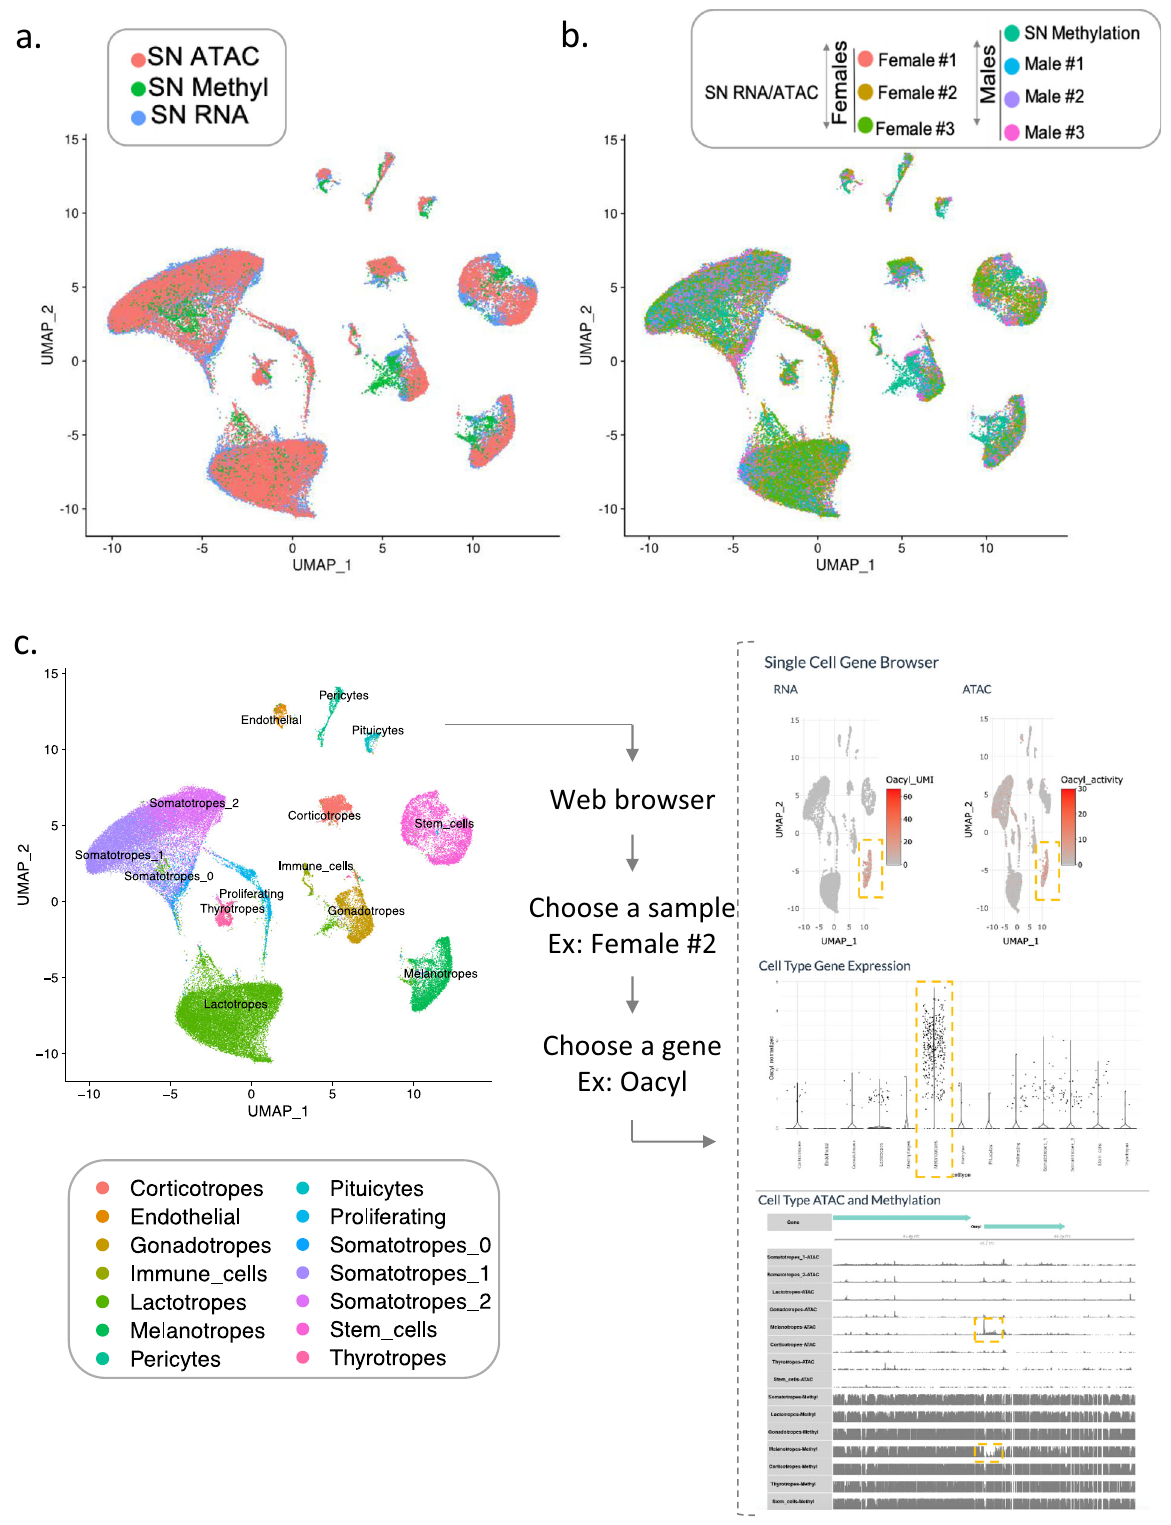
Fig. 5 Multi-omics pituitary cell type integration. a UMAP overlay of the snATACseq (red), snMethyl (green), and snRNAseq (blue) datasets. b UMAP of the overlay of all samples with the three omics modalities. SnRNAseq and snATACseq data are color-coded by animal. Male snMethyl data are also included. c Left panel, UMAP showing the cluster identi fi cation per cell type based on the snRNAseq annotations. Right panel, view of the web portal output. From the integrated datasets, users can access any information on gene expression, chromatin accessibility, and methylation status from our web portal